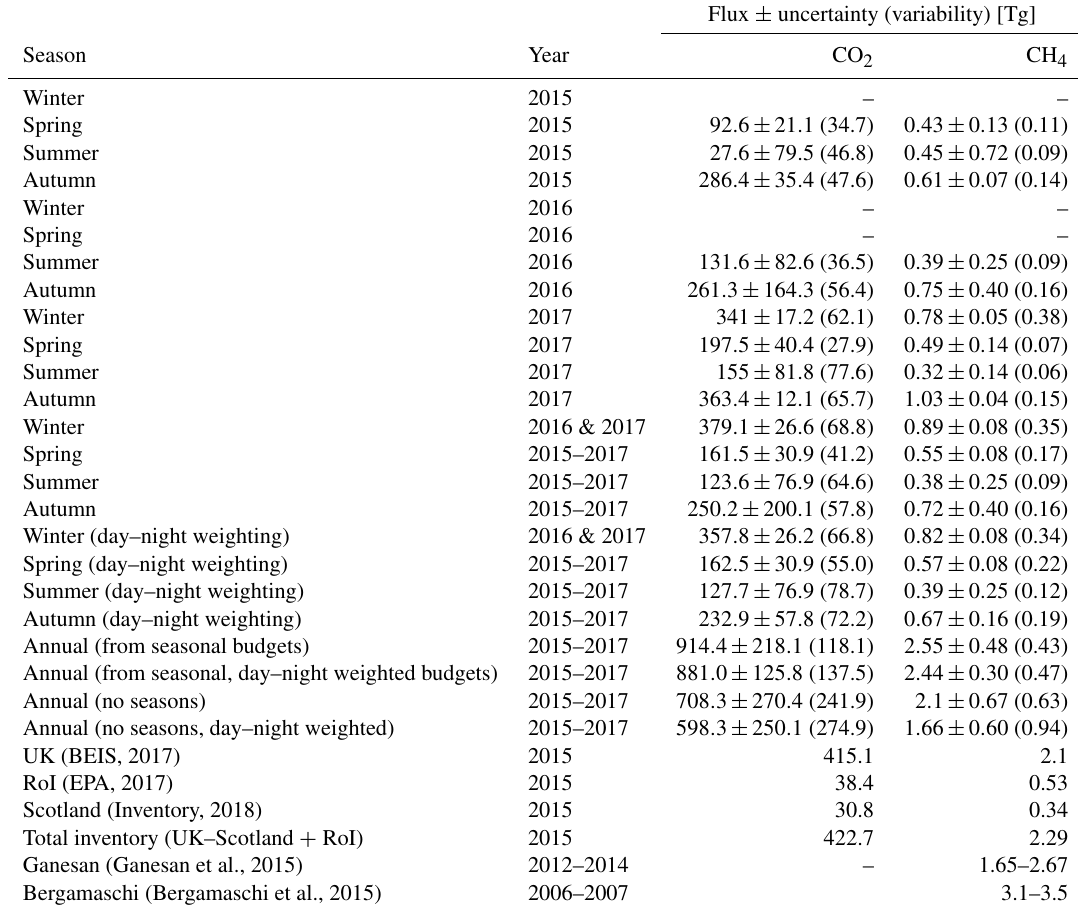
Table 3. Seasonal and annual budgets for CO 2 and CH 4 for the United Kingdom (excluding Scotland) and Ireland estimated by a mass balance approach using concentrations measured at the Mace Head station (Republic of Ireland; 53 ◦ 19 (cid:48) 19.2 (cid:48)(cid:48) N, 9 ◦ 54 (cid:48) 3.599 (cid:48)(cid:48) W) and on board the freight ferry which served the Rosyth (Scotland, UK; 56 ◦ 1 (cid:48) 21.611 (cid:48)(cid:48) N, 3 ◦ 26 (cid:48) 21.558 (cid:48)(cid:48) W) to Zeebrugge (Belgium; 51 ◦ 21 (cid:48) 16.96 (cid:48)(cid:48) N, 3 ◦ 10 (cid:48) 34.645 (cid:48)(cid:48) E) route. Seasonal budgets were calculated by year when sufficient data were available; seasonal budgets were also derived using the entire dataset with and without segregation of the raw fluxes into day and night components. Annual budgets were calculated with and without seasonality and with and without day–night segregation. The variability and uncertainty terms were calculated using Eq. (4) and Eqs. (7)–(8),